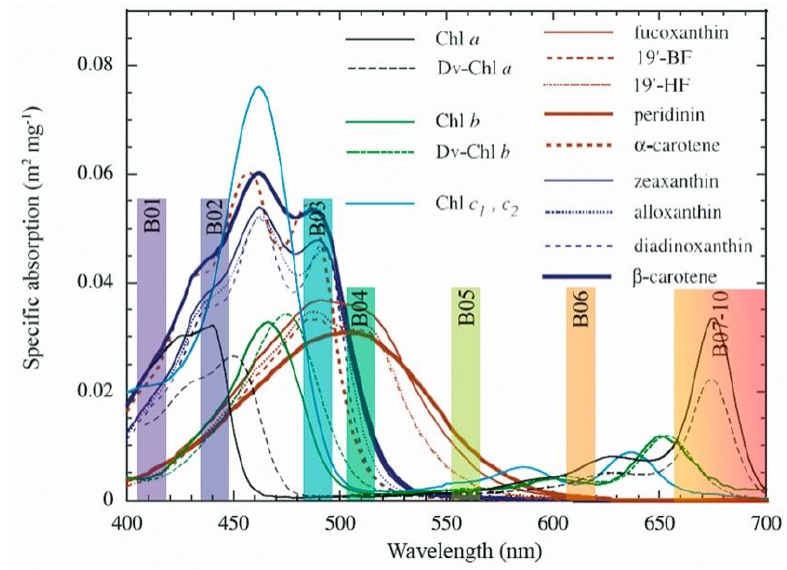
Figure 1. Weight-specific (or pigment-specific) in vitro absorption spectra of various pigments, adapted from Bricaud, 2004, and Sentinel-3/Ocean and Land Color Instrument (OLCI) sensor bands used (B01 to B10).